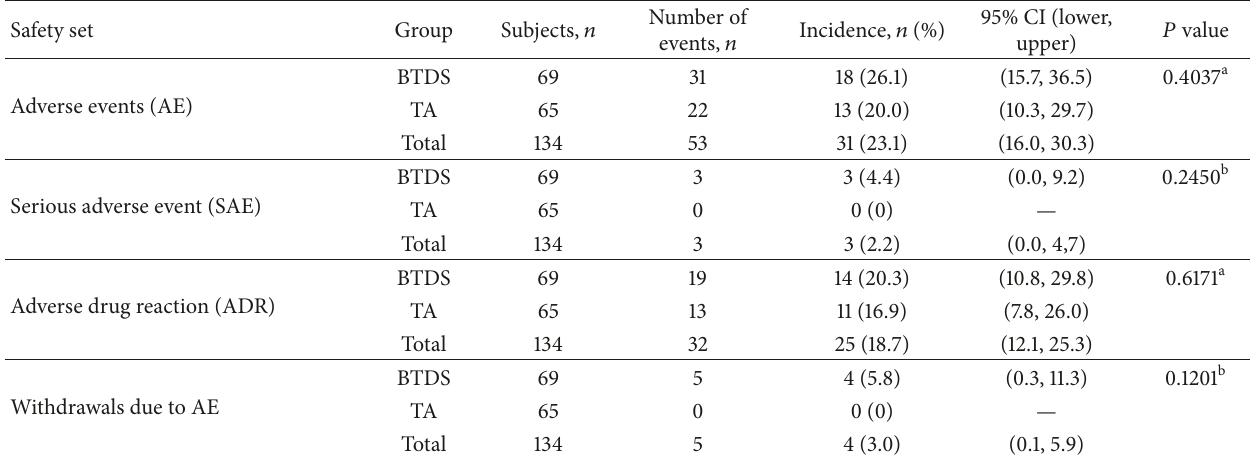
Table 5: Adverse